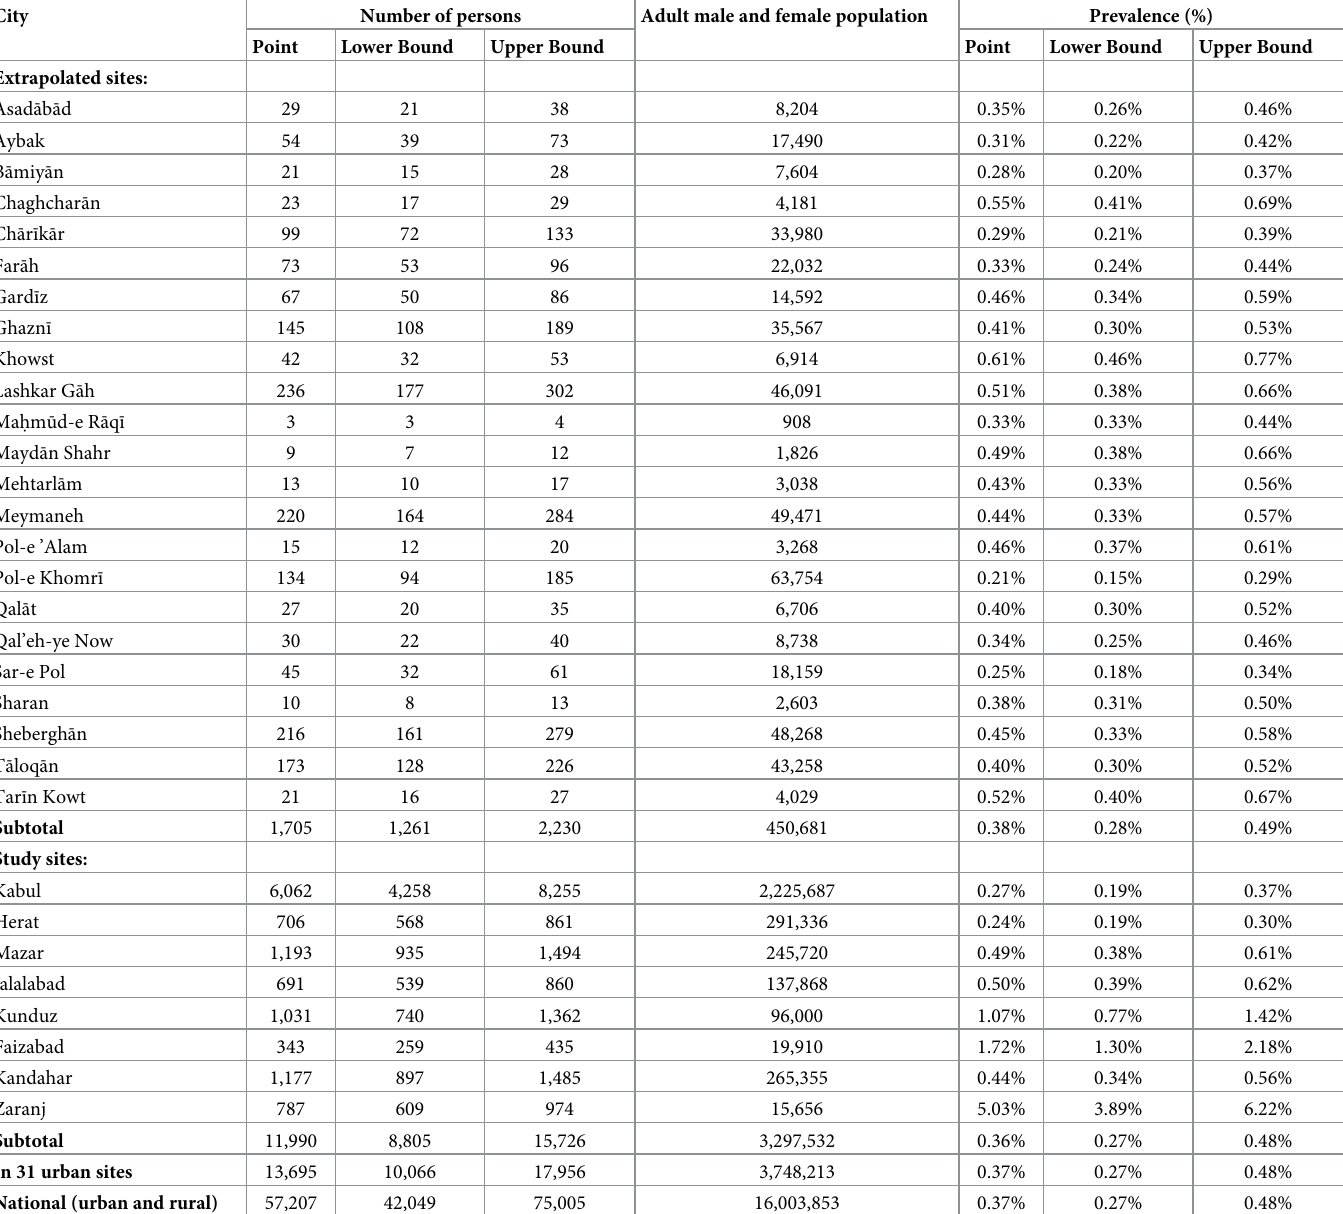
Table 10. Extrapolated population size and prevalence estimates for male and female people who inject drugs (PWID) in the adult population (15–64 years old) in major cities in Afghanistan, and at the national level in 2019 (adjusted for winter seasonality